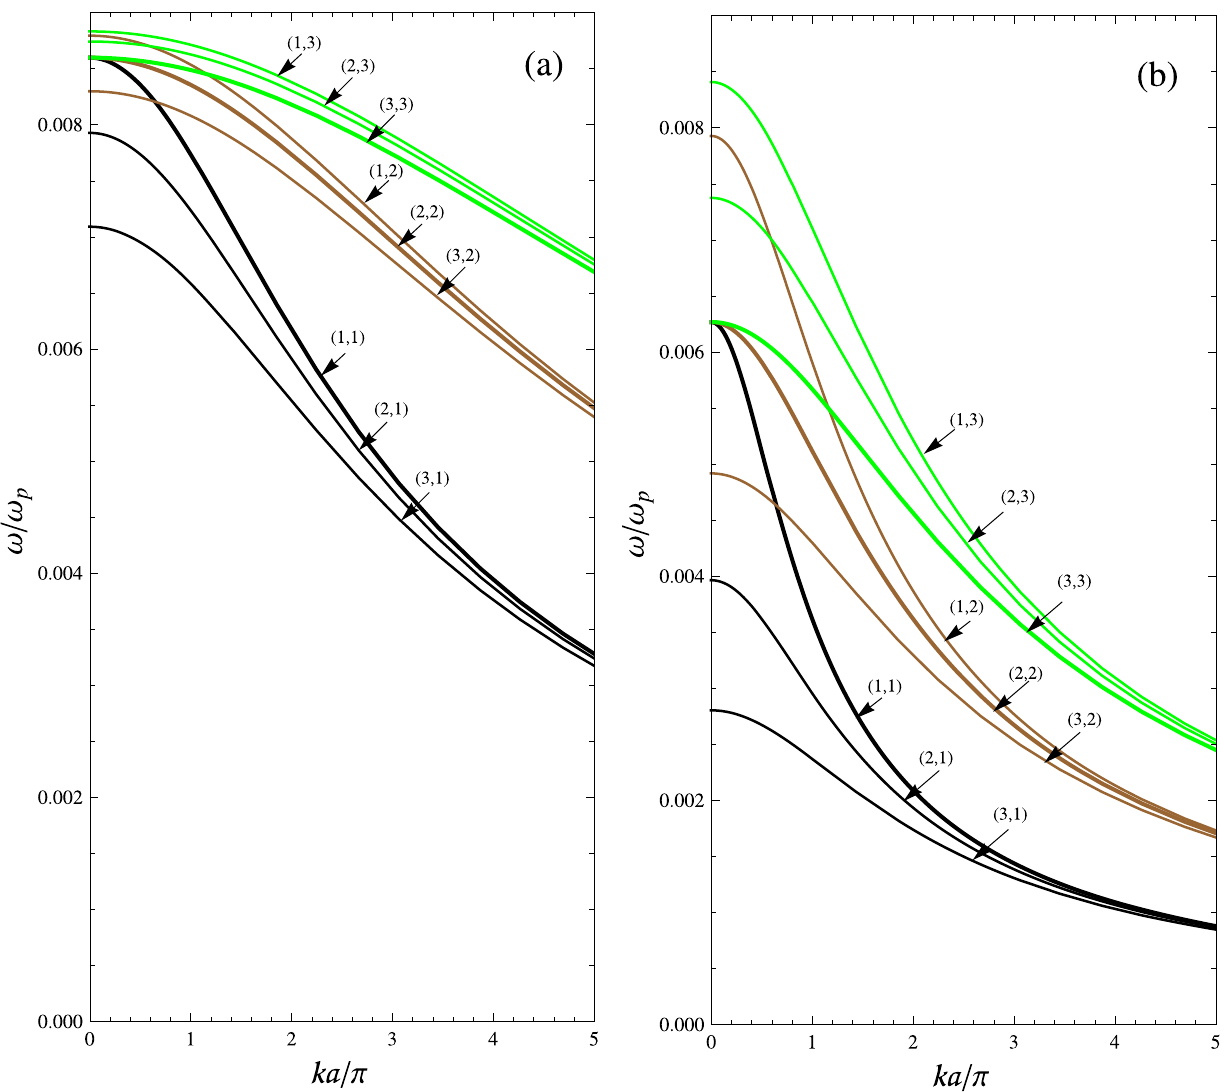
Figure 3. Dispersion curves of electrostatic modes ( m , n ) of a waveguide filled with a medium of nanowire- 5 nm, d 1 µ m and PEC boundaries, for n based HMMs with r = = 2 a w ), using Eq. (23). ( b ) A square waveguide ( h waveguide ( 2 h = =